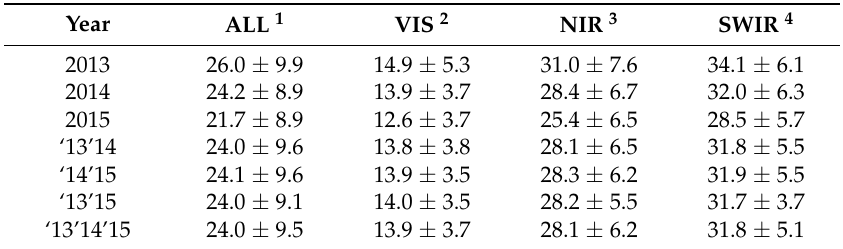
Table 8. Table 8. Mean and standard deviation of the reflectance values for the individual and multi-temporal images.